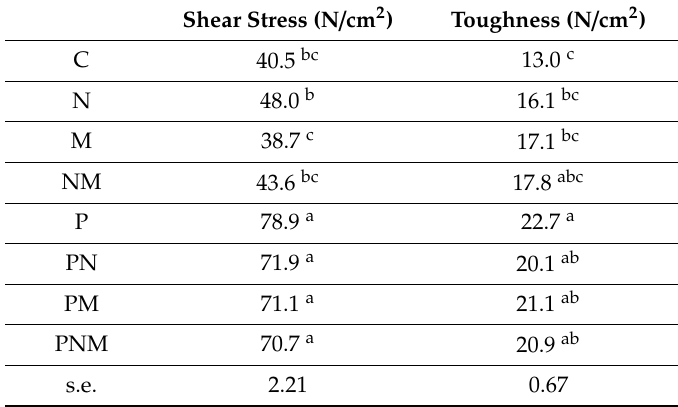
Table 4. The means and standard errors of beef shear stress and toughness as a function of